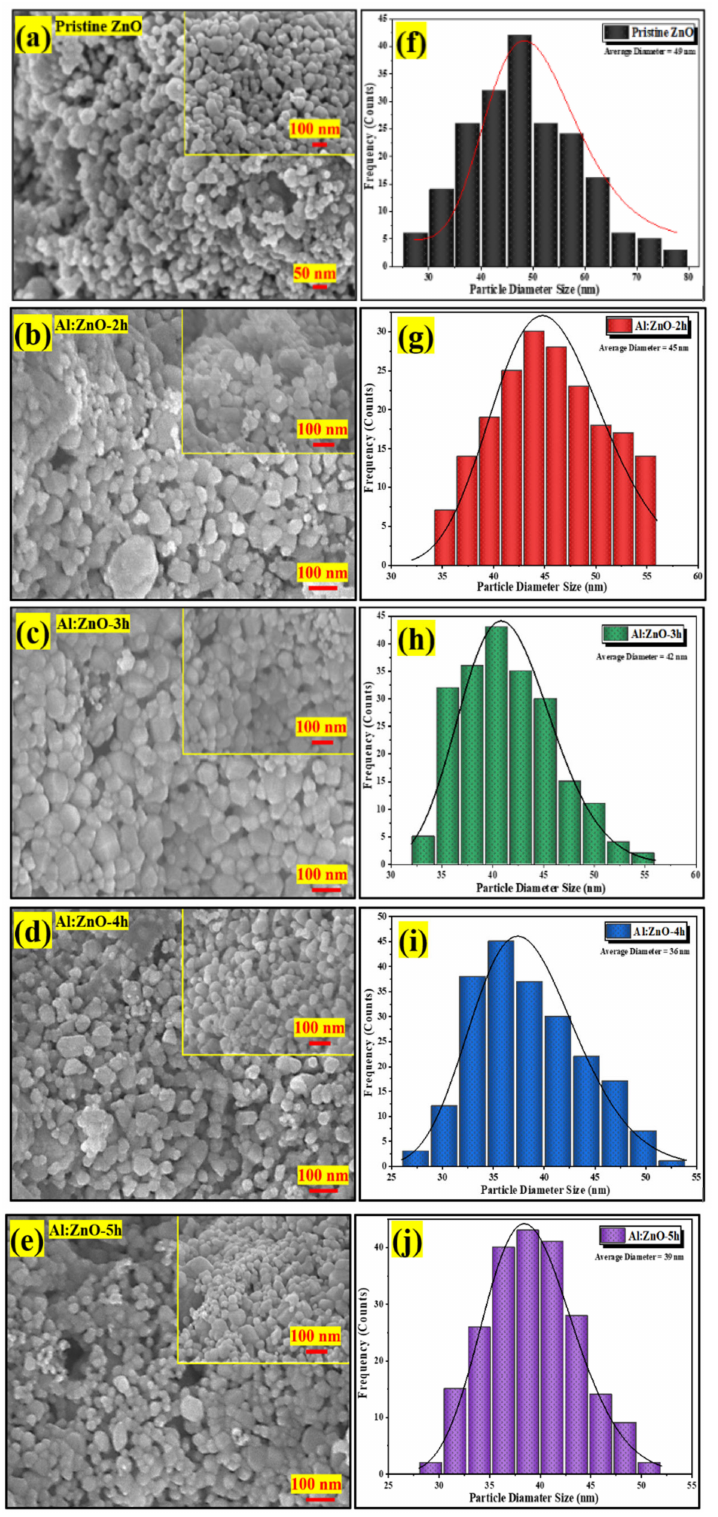
Figure 7. FESEM micrographs of the nanostructured powders and the corresponding histogram of the nanoparticle diameter size at different immersion times: ( a , f ) pristine ZnO; ( b , g ) Al:ZnO-2 h; ( c , h ) Al:ZnO-3 h; ( d , i ) Al:ZnO-4 h; and ( e , j ) Al:ZnO-5 h at 95 ◦